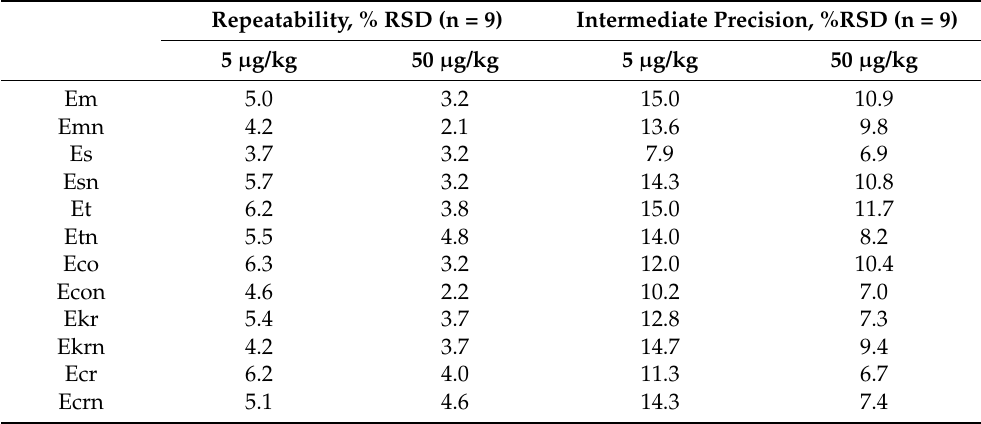
Table 2. Precision of the proposed method for the determination of main EAs and their epimers in spiked oat flake